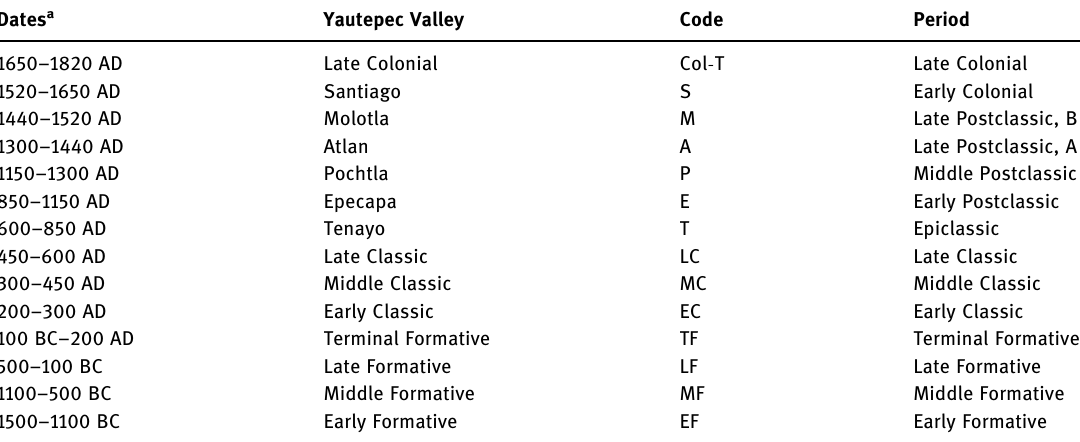
Table 1: Chronological periods in the Yautepec